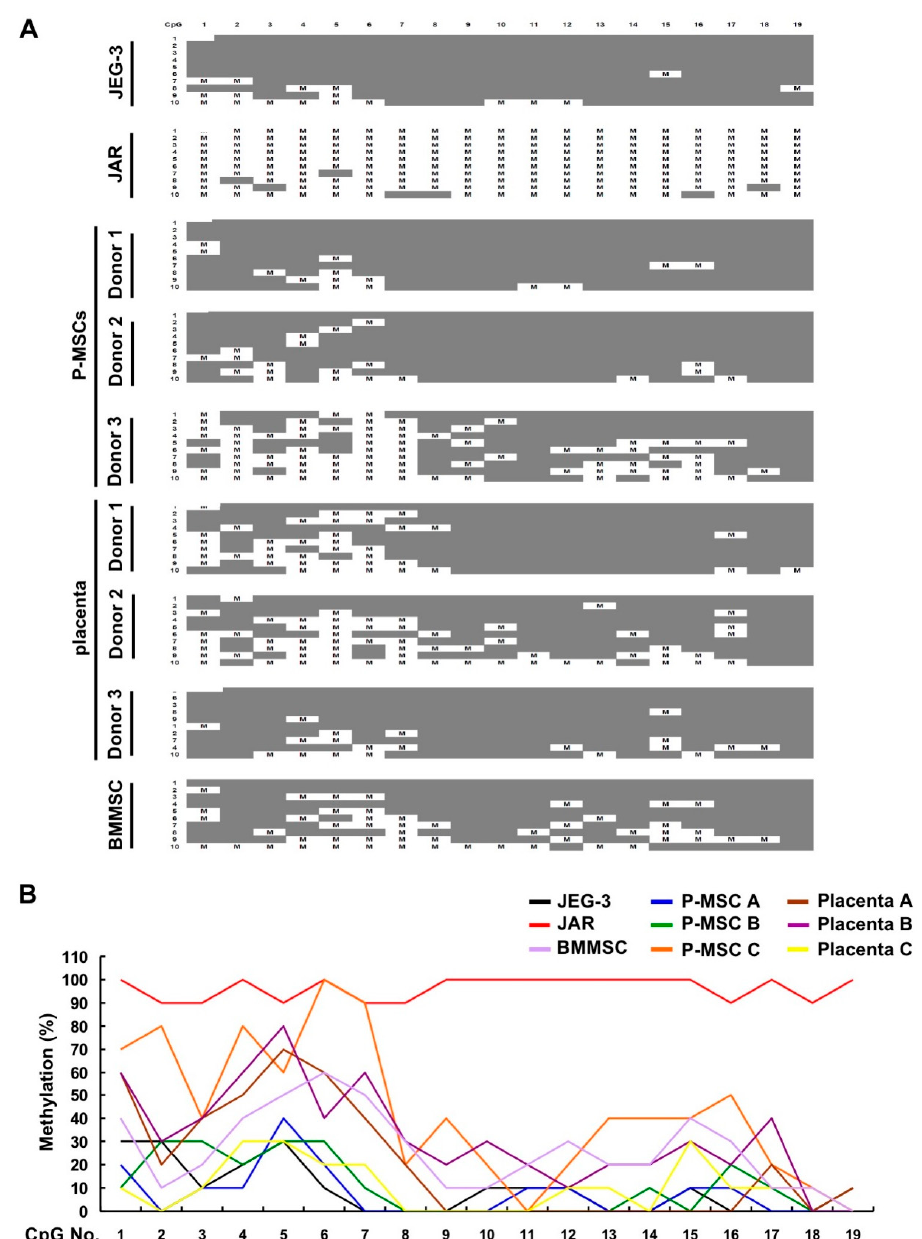
Figure 4. An overall hypomethylation pattern is seen in the HLA-G proximal promoter CpG sites of human MSCs and placental tissue extracts. ( A ) Region I (from +391 to ATG; 473 bp containing 19 CpG sites) of genomic DNA obtained from JEG-3, JAR, P-MSCs (3 donors), BMMSCs (1 donor), and placenta (3 donors) were sequenced after bisulfite modification with 10 bacterial clones of PCR products sequenced for each sample. Gray boxes, unmethylated CpG site; M, methylated CpG site. ( B ) Quantification of the percentage of individual CpG site which are methylated in Region I for each cell/tissue type. Methylation (%), percentage of total methylation per CpG site.